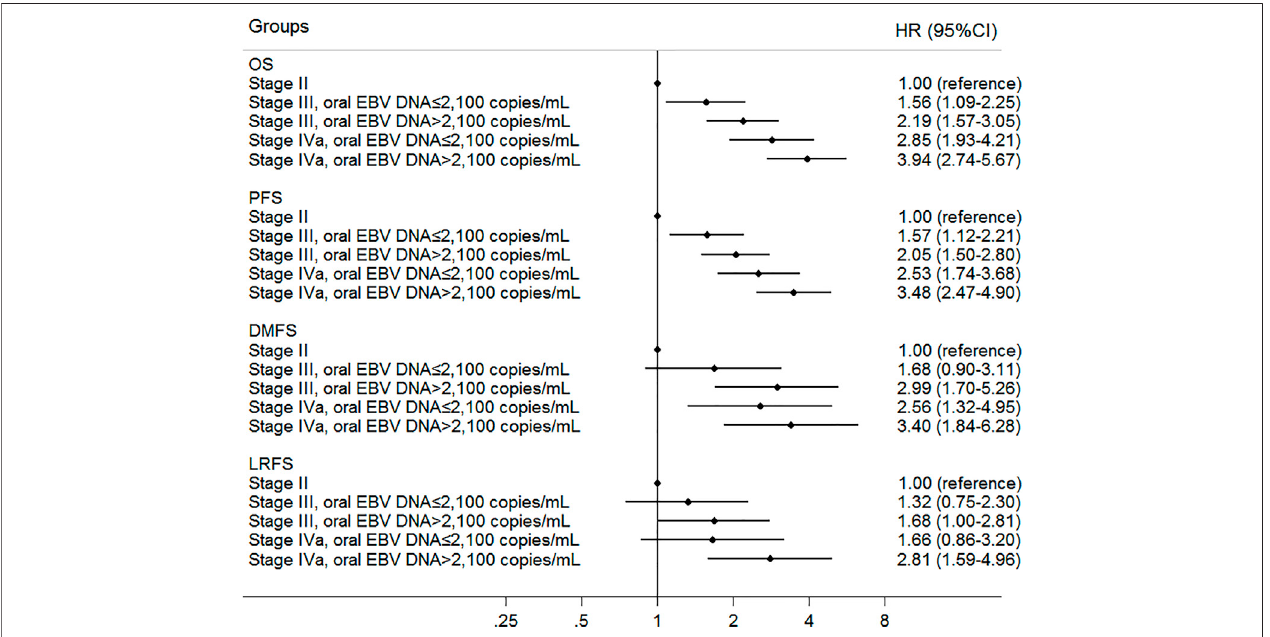
FIGURE 4 | Multivariate associations of new groups de fi ned by oral EBV DNA level and TNM staging with survivals in all 1,194 NPC patients. Survivals included overall survival (OS), progression-free survival (PFS), distant metastasis – free survival (DMFS), and locoregional relapse-free survival (LRFS).